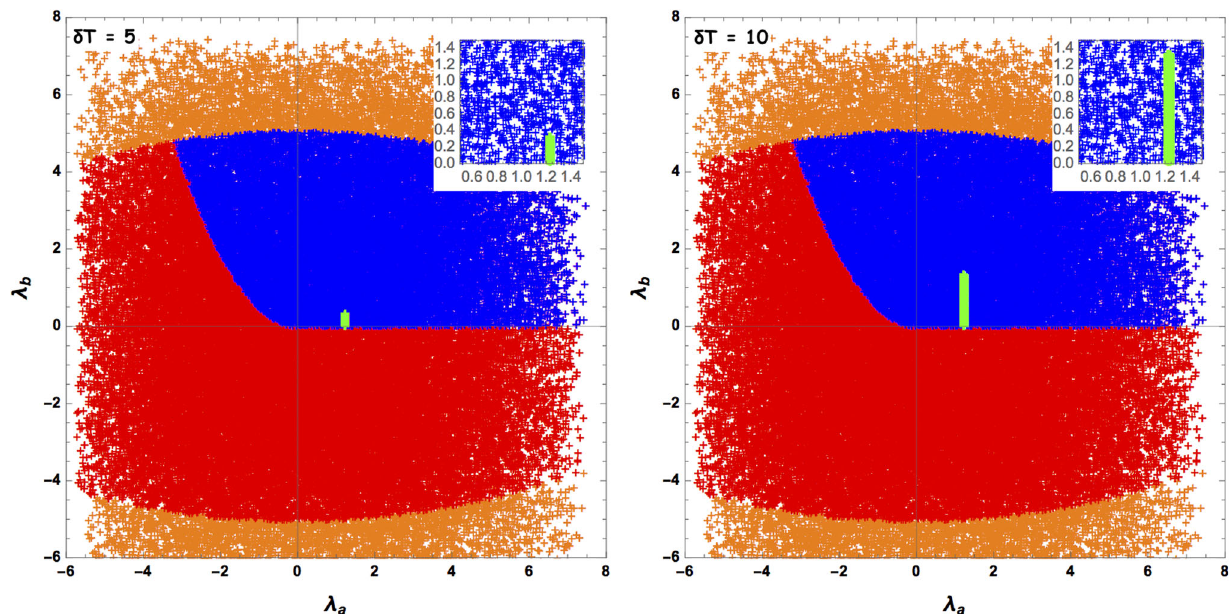
ALLOWED region of the parameter space obeying to all theoretical constraints. Our inputs are: λ = 0 . 52, − 5 ≤ λ 1 ,λ 2 ,λ 3 ,λ 4 ,λ 5 ≤ 5, v = 1 GeV and 2 ≤ μ ≤ 5 t